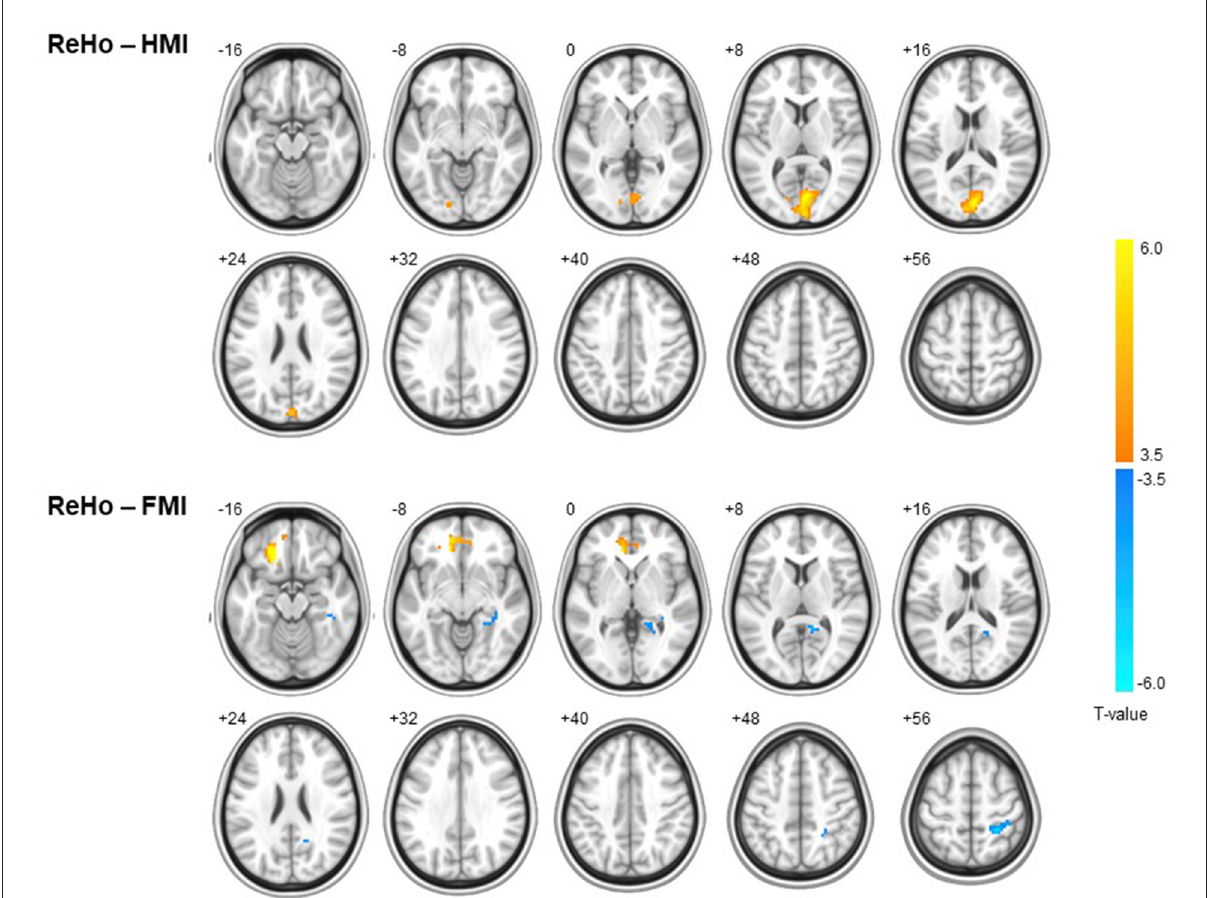
FIGURE2 Within-group differences in ReHo in the HMI (upper panel) and FMI groups (lower panel). A warm color indicates increased ReHo at follow-up, and a cool color indicates decreased ReHo. In the HMI group, increased ReHo was evident only in the cuneus at follow-up, whereas increased ReHo in the medial orbitofrontal gyrus and anterior cingulate and decreased ReHo in right superior parietal lobule and precuneus were observed in the FMI group. FMI, facility-based multidomain intervention; HMI, home-based multidomain intervention; ReHo, regional homogeneity.